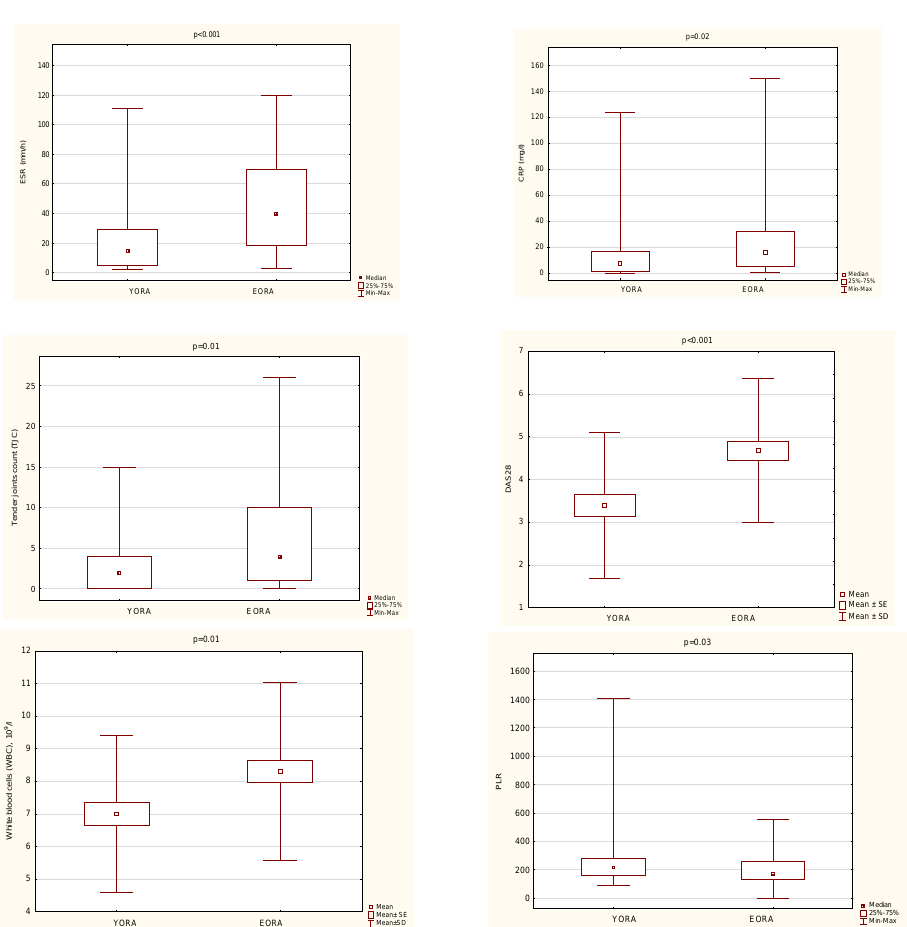
Figure 1. Significant differences between patients with YORA vs. EORA.